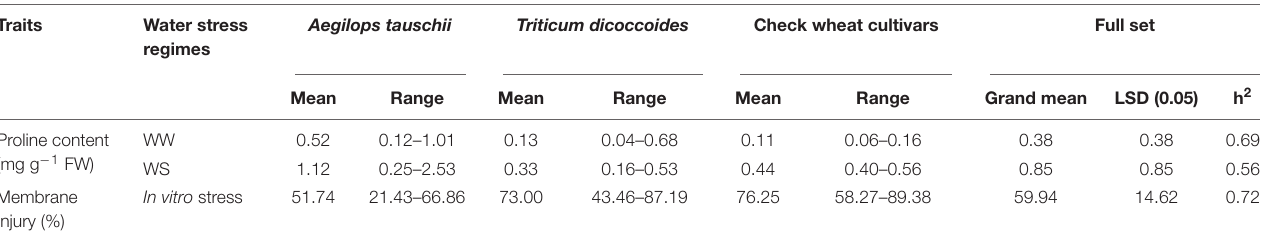
TABLE 2 | Genotypic variation in wheat germplasm set for leaf tissue based traits (stress developed under field conditions) recorded under well waterd and water stress conditions. Traits Water stress regimes